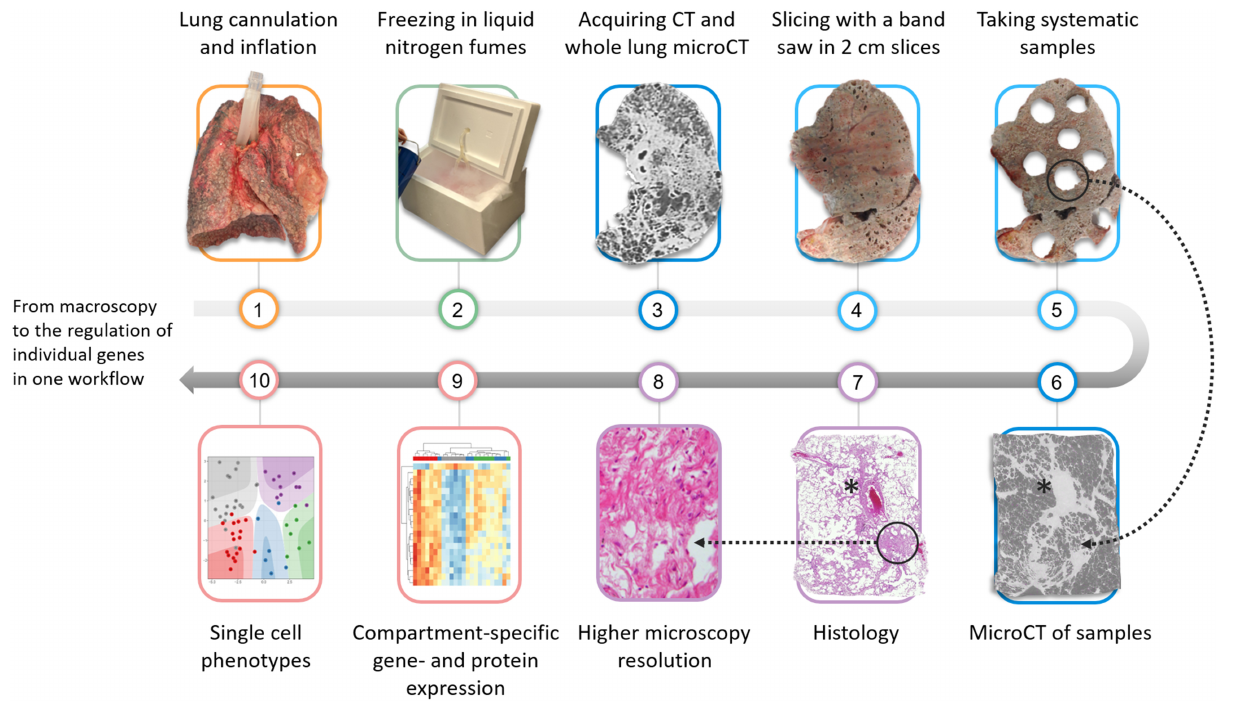
FIGURE 1 | Overview of the proposed protocol that can be used to investigate the lung from macroscopy to microscopical ultrastructure. The lung is firstly cannulated via the main stem bronchus and inflated using a compressed air source and subsequently fixed in liquid nitrogen fumes. Following an ex-vivo CT and microCT, the lung is sliced in 2cm slices and samples are systematically extracted using a core bore or power drill. Pre-selected or randomly selected samples can be scanned with microCT to further improve the spatial resolution. Further validation can be performed with histopathology. More downstream possible molecular analysis includes compartment-specific gene expression analysis or single nuclear analysis which can be used to elucidate specific pathways in pathological areas. *blood